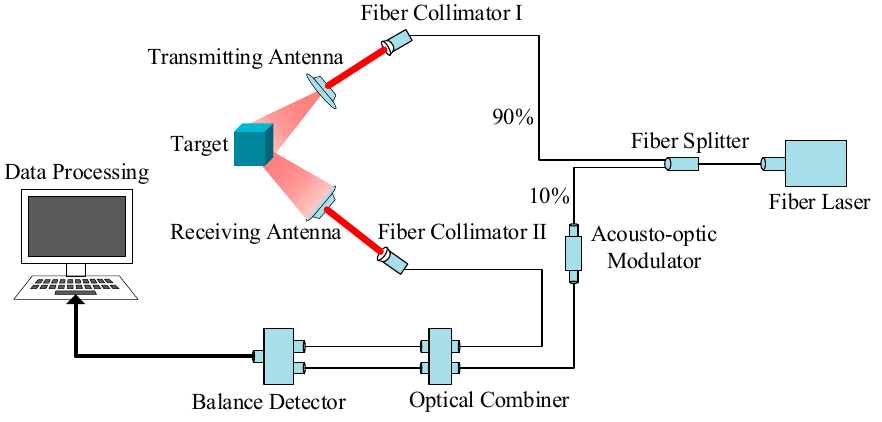
Figure 8. Schematic diagram of laser micro-Doppler detection.